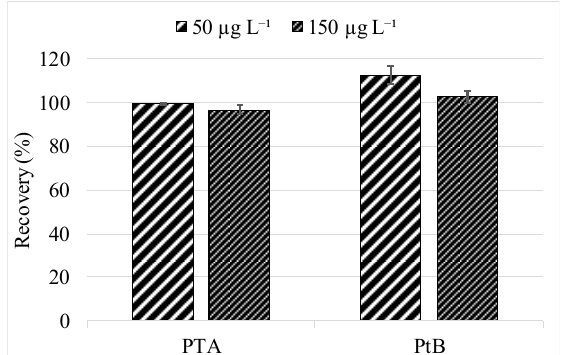
Figure 4. Recovery of PTA and PtB at 50 µ g L − 1 and 150 µ g L − 1 in spiked raw groundwater (Vigersted) handled according to the preservation protocol (48 h between spiking and analysis; 95% confidence limit; n = 6). The error bars represent relative standard deviation (RSD).